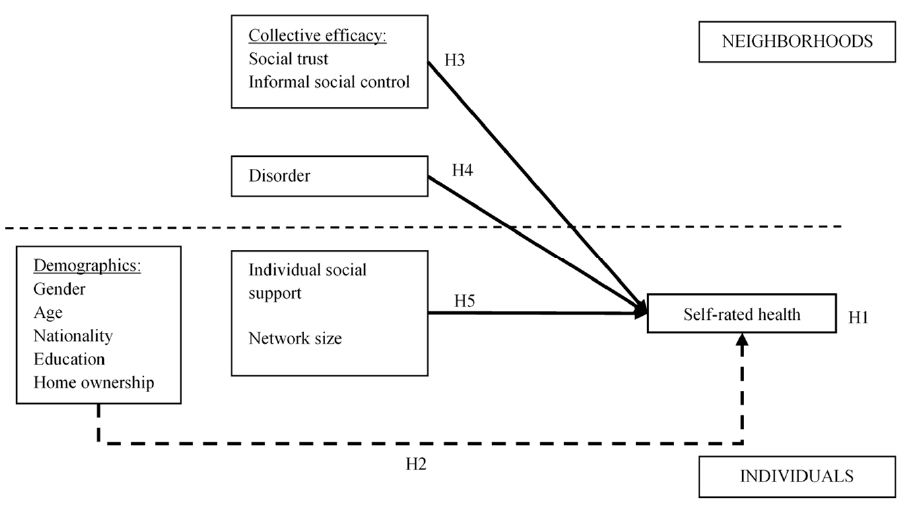
Figure 1. Contextual model–Hypothesized effects on self-rated health.